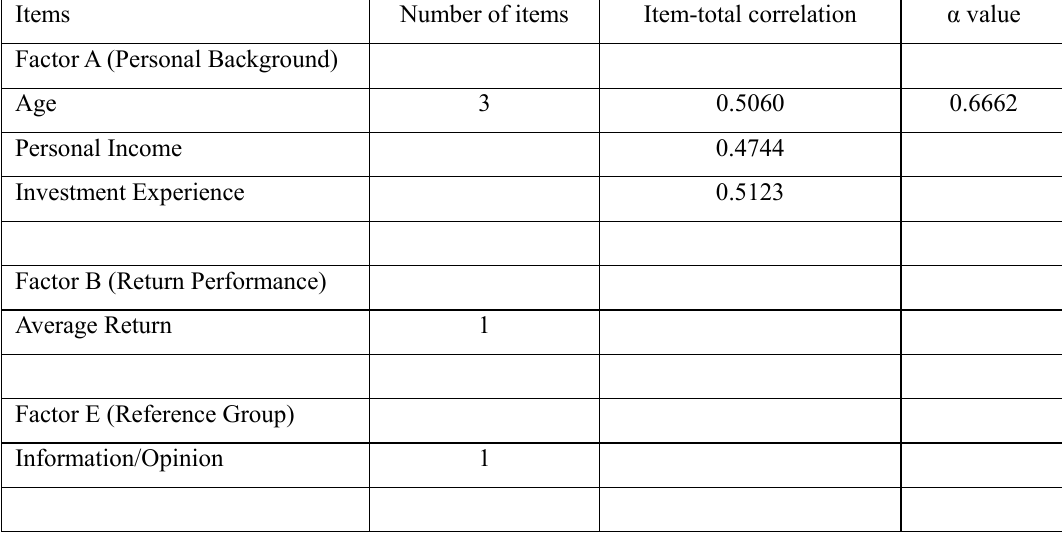
Table 7: Internal consistency of final revised